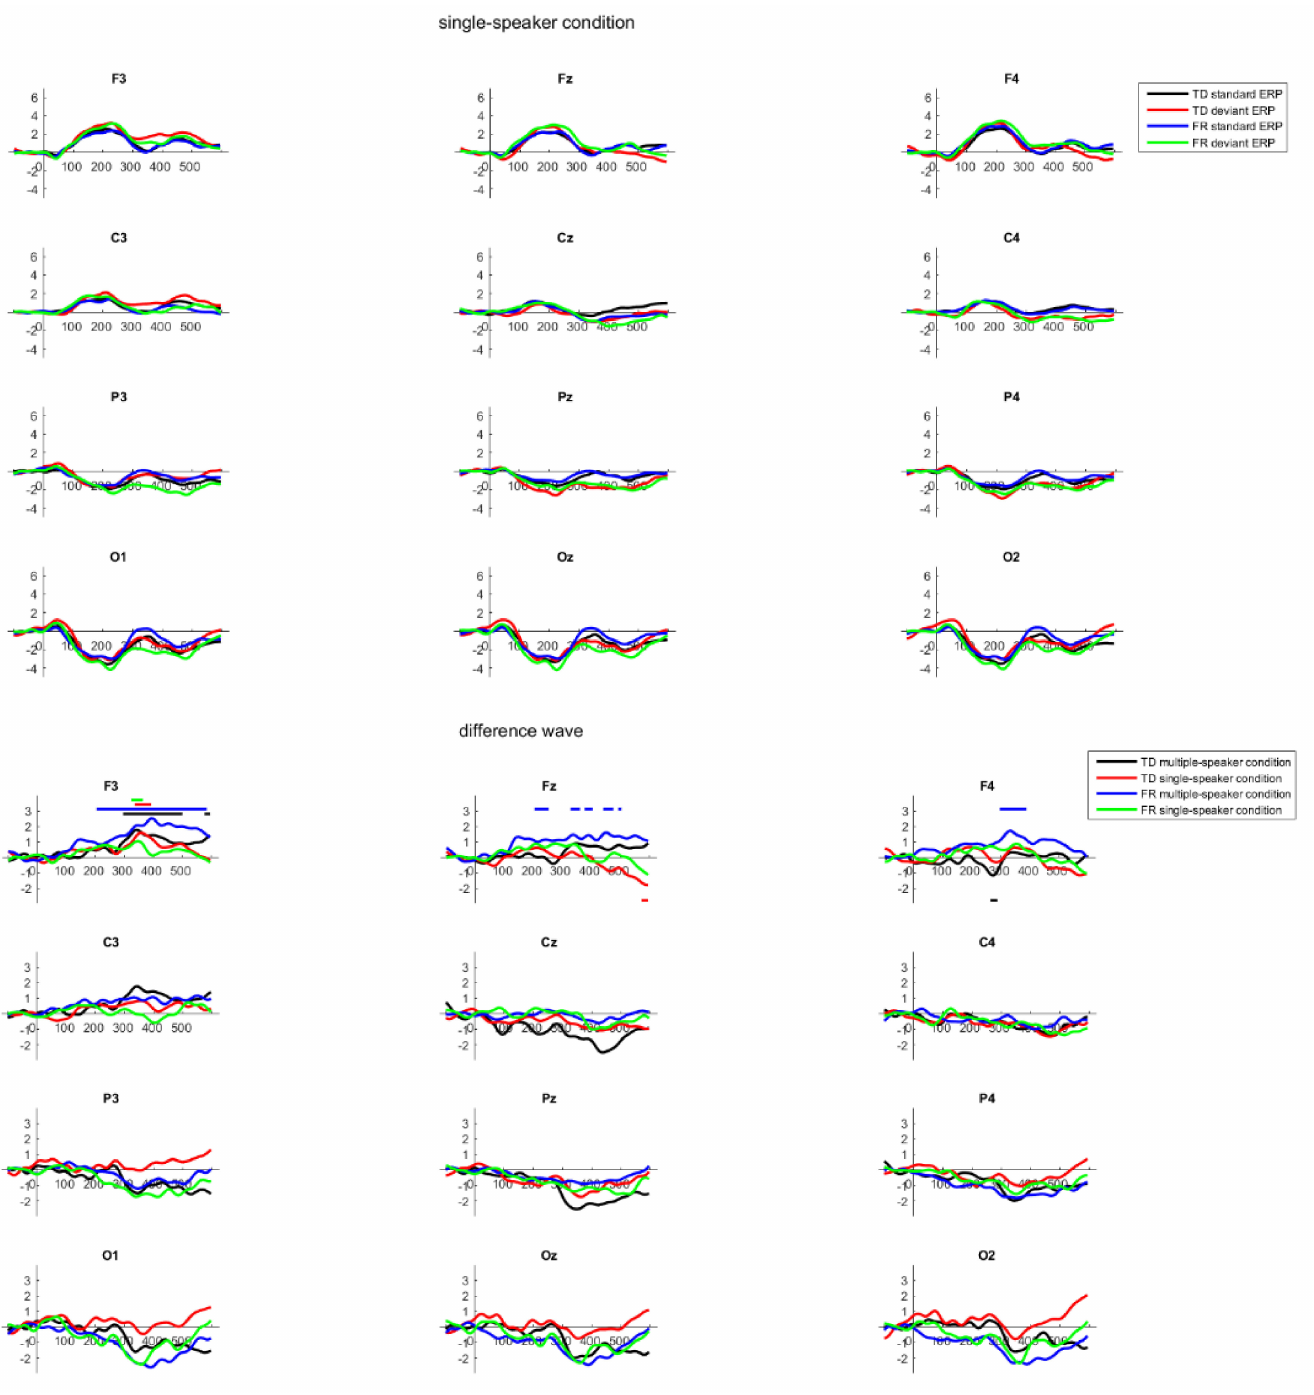
Figure 2. Standard ERPs, deviant ERPs, and difference waves of the typically developing TD children and children at familial risk of dyslexia (FR) in the multiple-speaker and single-speaker condition. The bars in the difference wave graphs indicate the time windows where the mismatch responses (MMRs) MMRs were significant, with the bars’ colors corresponding to group membership. Bars above the ERP waves indicate positive MMR, and bars below the ERP waves indicate negative